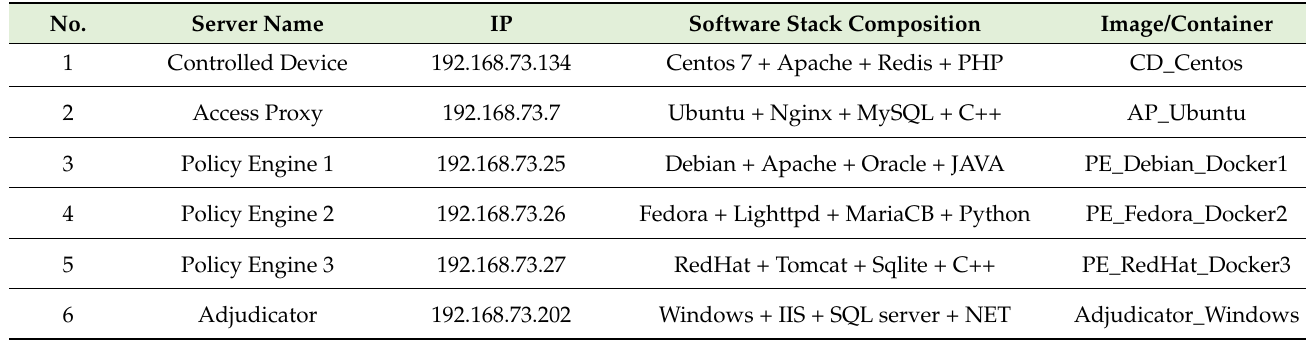
Table 2. System component